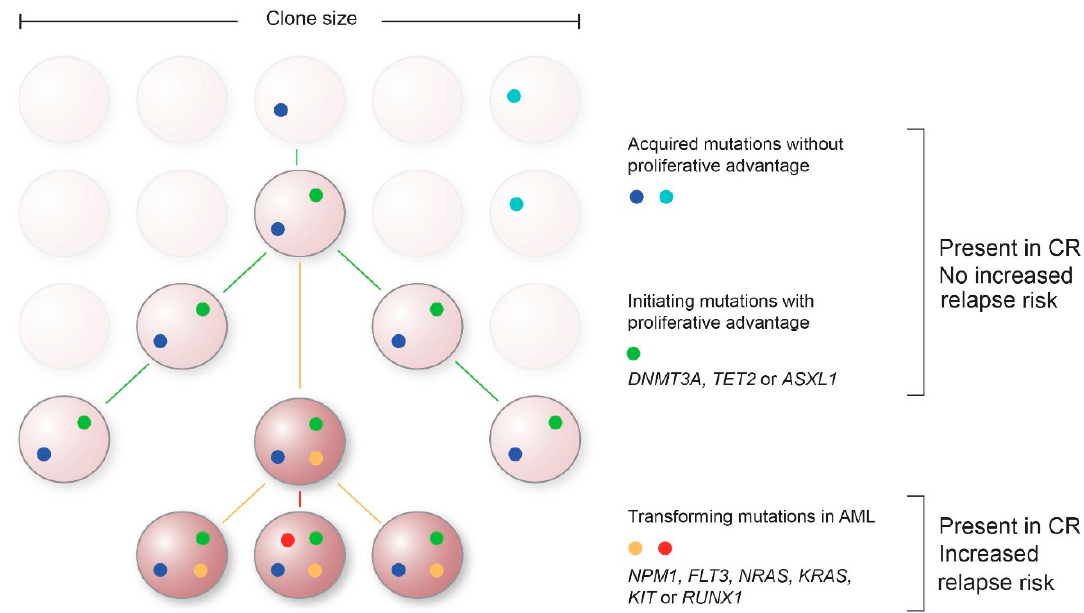
Figure 1. Proposed model of acquisition of mutations over time and their contribution to AML. Mutations without proliferative advantage will occur over time in hematopoietic progenitor cells ((light)blue) that do not contribute to leukemogenesis. Subsequently, initiating clonal hematopoiesis-associated mutations with proliferative advantage can arise, such as mutations in DNMT3A, TET2 and ASXL1 ( DTA ) (green). These mutations when persisting in complete remission (CR) typically do not show an association with an increased risk of relapse. Late event mutations in genes such as NPM1, FLT3, NRAS, KRAS, KIT, or RUNX1 are representative for transformation to AML (non- DTA mutations, red/yellow). Persistence of these non- DTA mutations in CR are associated with an increased risk of relapse.